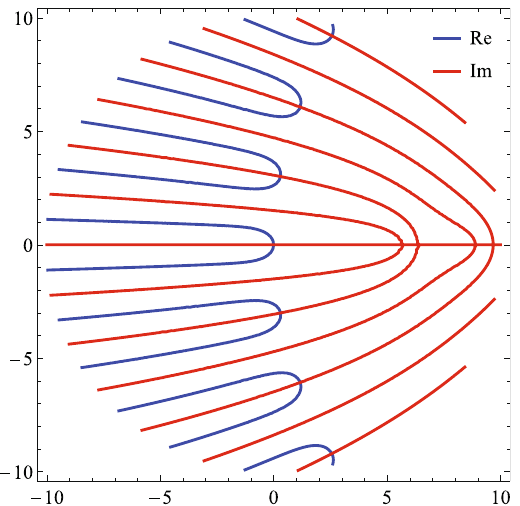
Figure 2. Spectral analysis of the hard model. κ = 0.1, τ = 1, x − = − 2, x ↓ = − 1, x ↑ = 1, x + = 2. The axes are Re[ λ n ] and Im[ λ n ]. Red and blue lines mark isolines of the real and imaginary parts of det( M ( λ )), respectively (see Supplementary Information (SI) for details). Any crossing of a blue line and a red line corresponds to an eigenvalue, λ n